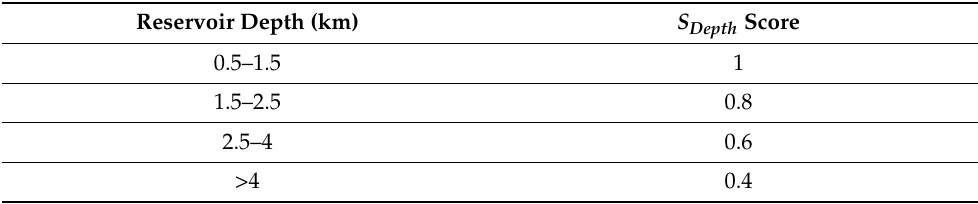
Table 7. The assessment rules of the reservoir depth.